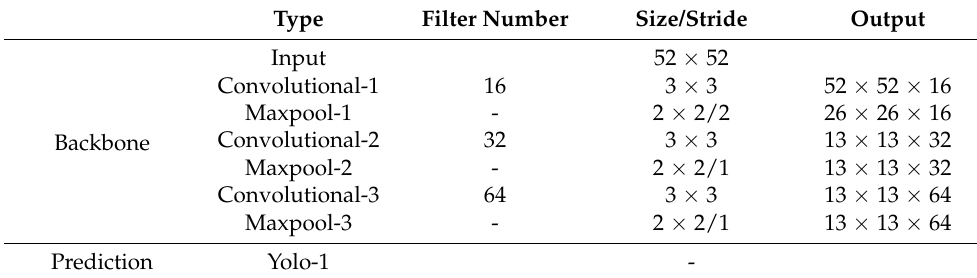
Table 1. S-YOLO network designed in this paper for ship target slice detection and